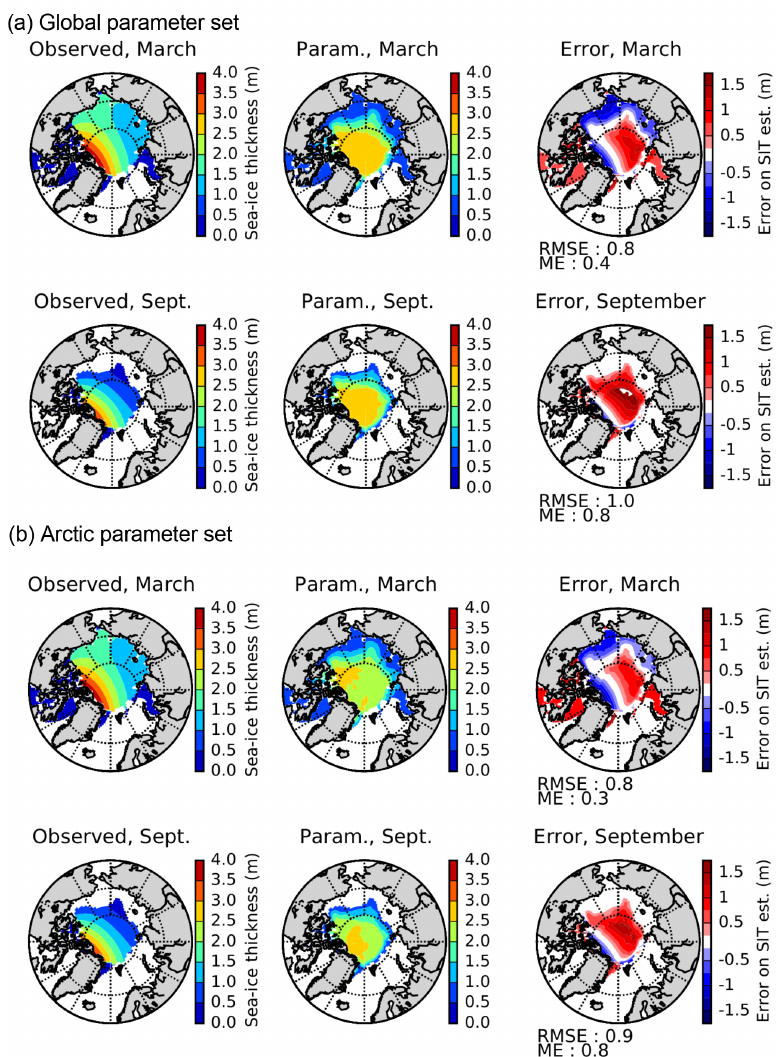
Figure 11. Observed (regressed, Lindsay and Schweiger, 2015) and parameterised Arctic SIT (in m) for March and September and the difference between these (right) with (a) the global parameter set and (b) the Arctic parameter